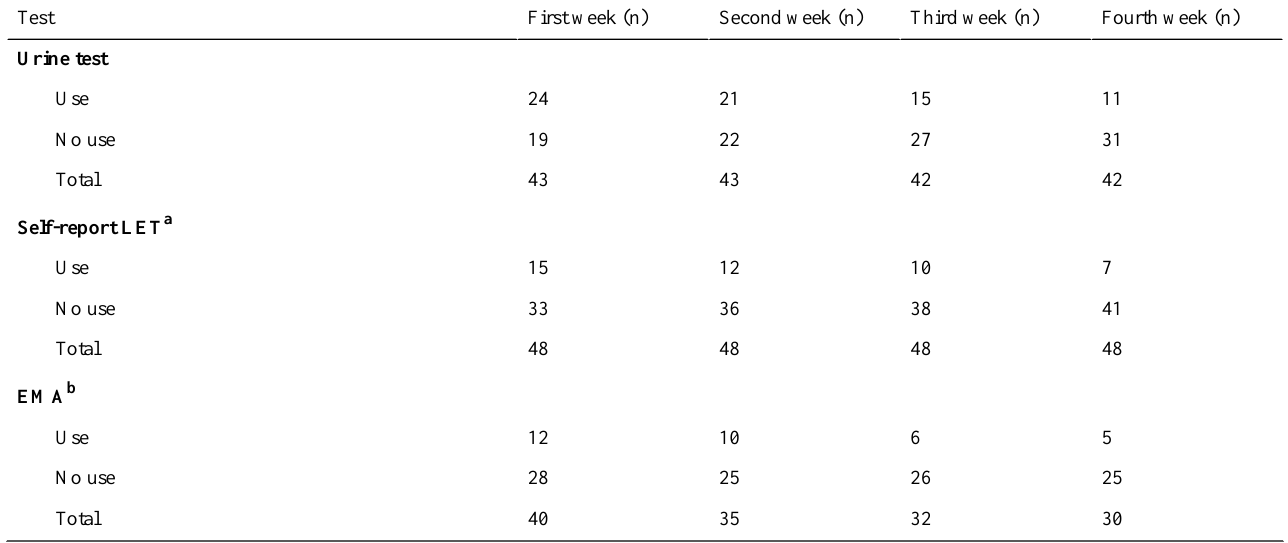
Table 2. Drug use test results by week.